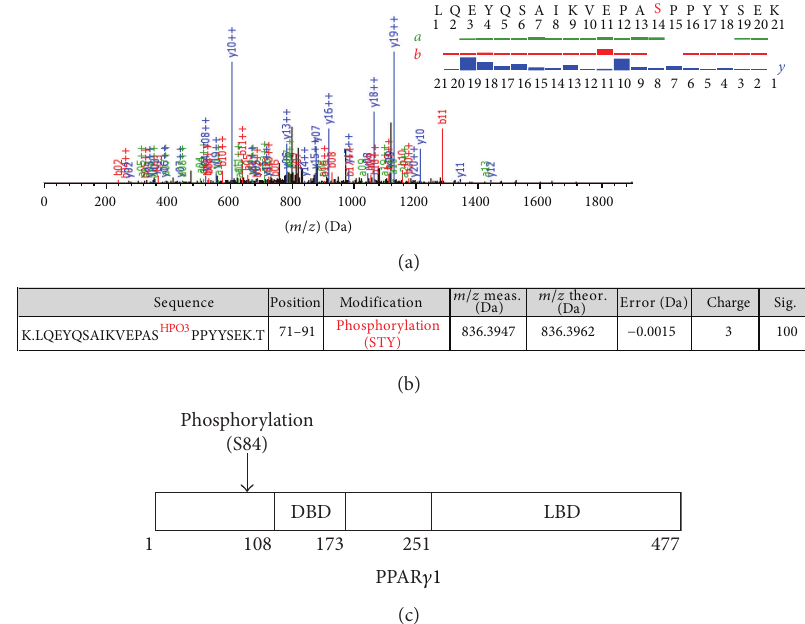
Figure 4: Identified PTMs in PPAR 𝛾 1 proteins from Caco-2 cells. (a) Representative MS/MS spectra of PPAR 𝛾 1 proteins of the peptide harboring [80-VEPAS HPO 3 PPYYSEK-91] assigned by MODIRO are shown. (b) List of identified PTMs in endogenous PPAR 𝛾 1 proteins using ion trap MS/MS. (c) Diagram for summary of identified PTM in endogenous PPAR 𝛾 1